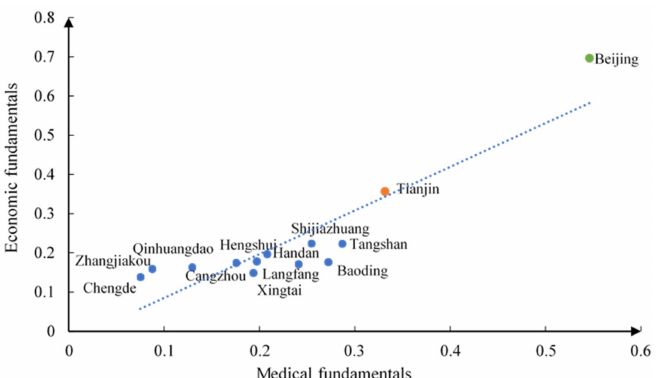
Figure 5. Urban fundamentals of the Beijing–Tianjin–Hebei urban